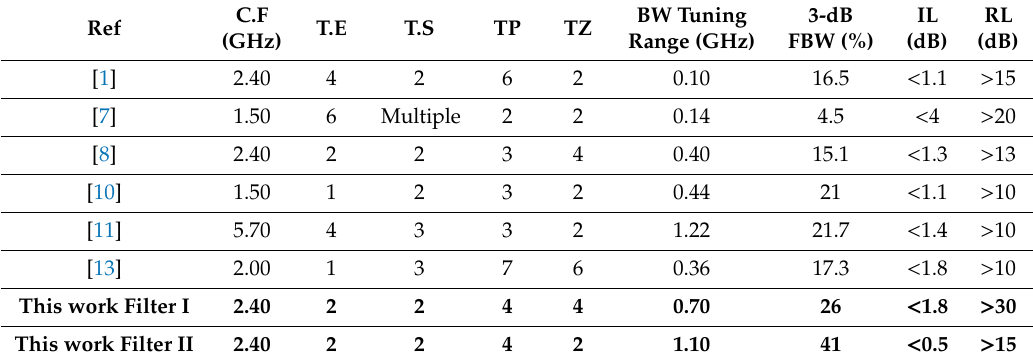
Table 4. Comparison with previous works * (Bold shows our design filtering parameters).